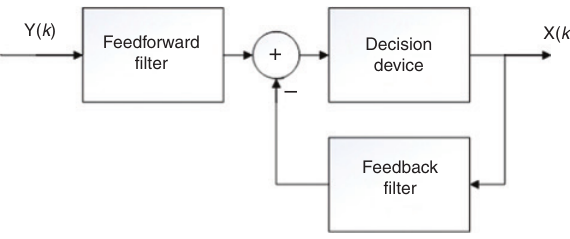
Figure 1: Generic DFE